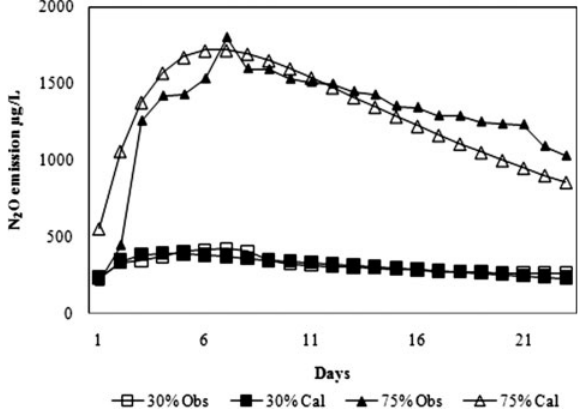
Fig. 1. Emission of N 2 O with the variation of WFPS